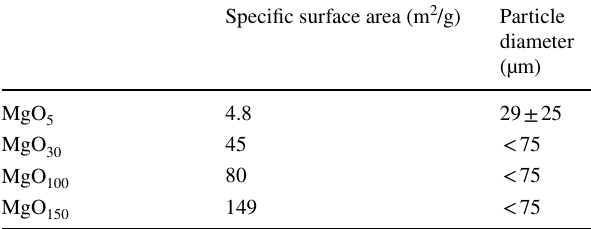
Table 1 Specific surface area and particle diameter of the various MgO used